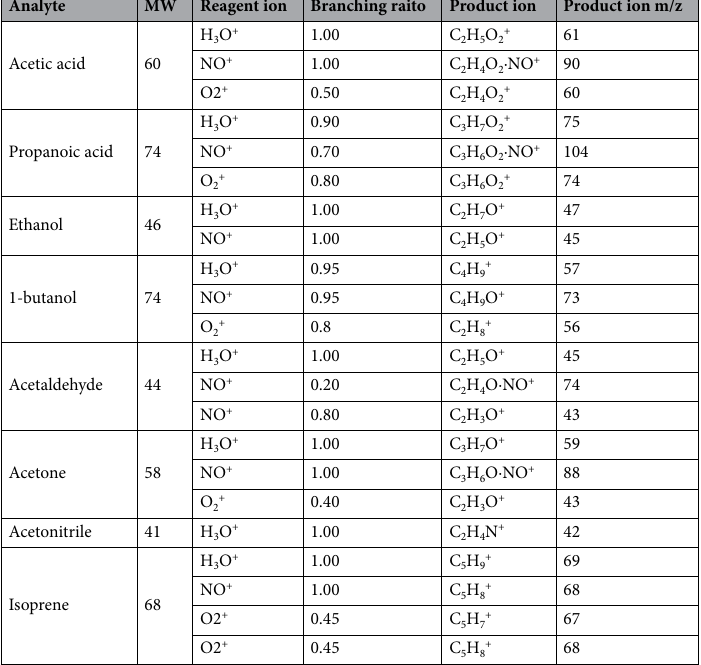
Table 2. Reagent and product ions for all volatile organic compounds analyzed. MW molecular